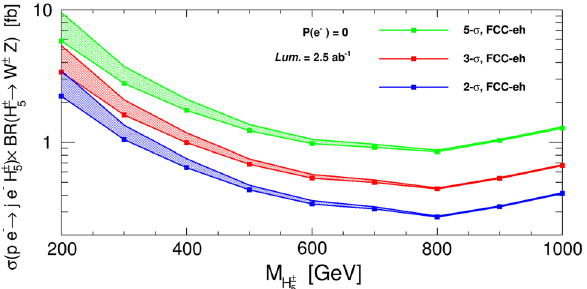
) × BR ( H ± → ZW ± ) as functions of M 5 5